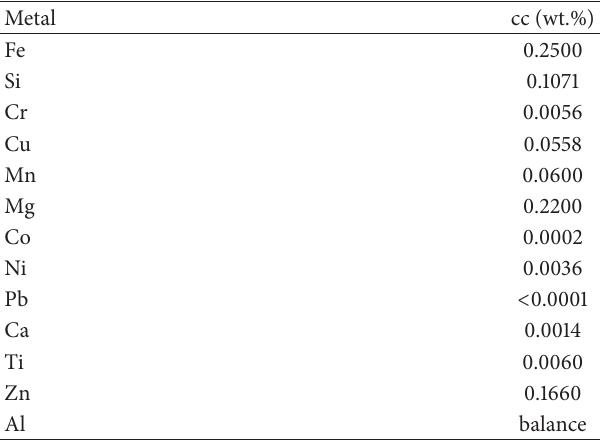
Table 1: Chemical composition (cc) of the aluminum alloy deter- mined by